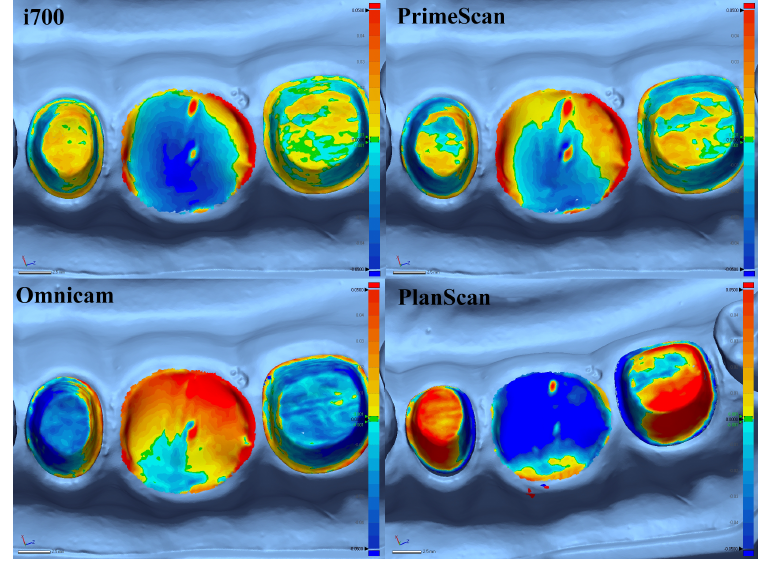
Figure 2. Trueness color-coded maps generated by the metrology